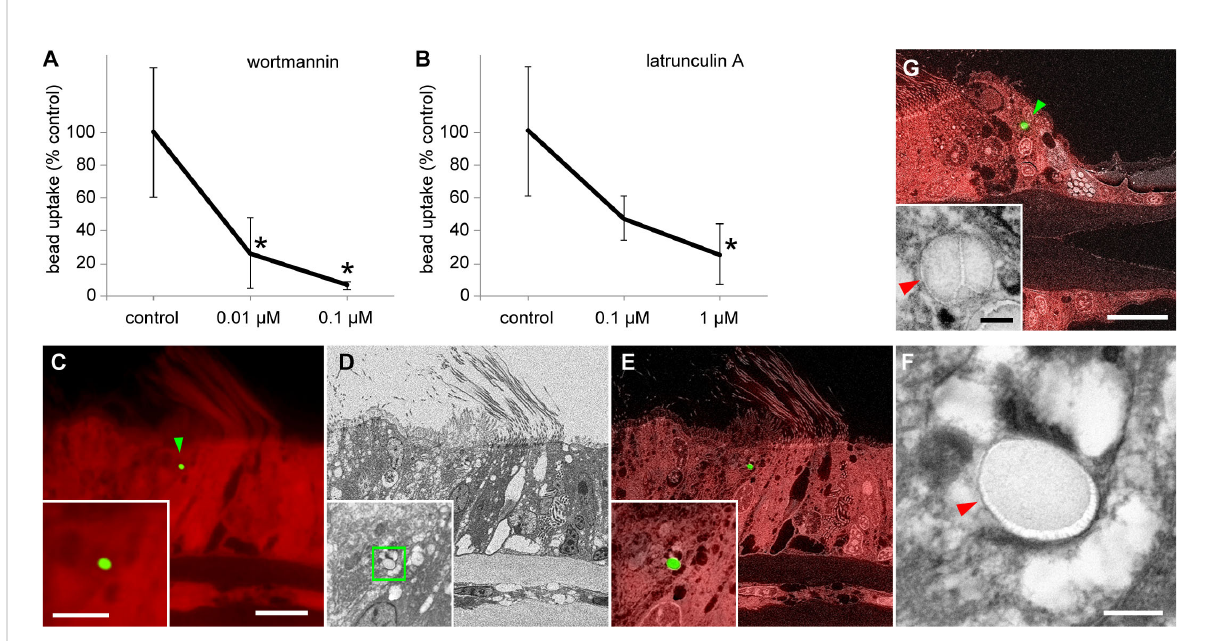
FIGURE 2 Cellular physiological and microhistological veri fi cation of phagocytosis of beads by gill cells. (A, B) Effects of wortmannin (A) and latrunculin A (B) on bead uptake by gill cells. After 24 h of bead exposure and simultaneous treatment with various concentrations of inhibitors, the number of beads internalized into cells was compared with that in control. Asterisks indicate a signi fi cant difference versus the control ( P < 0.05), with error bars representing standard deviation (n = 3). (C – G) Correlative observations of the beads internalized into gill cells using optical and scanning electron microscopy (SEM) with a backscattered electron detector; green arrowheads indicate internalized beads. (C – F) Bathymodiolus japonicus , (G) Perna viridis . (C) Red auto fl uorescence of gill tissues of B. japonicus and green fl uorescent signal of a bead (1 µm). (D) SEM image of the same area as (C) . (E) Merged image of fl uorescence microscopy and SEM. Insets in (C – E) show a higher magni fi cation of the bead in the same area. (F) Magni fi ed image that corresponds to the area indicated by the green square in the inset in (D) The bead is enclosed within a membrane-bound vacuole (red arrowhead). (G) Merged image of red auto fl uorescence of gill tissues of P. viridis and green fl uorescent signal of a bead, and SEM image of the same area. The inset shows a magni fi ed SEM image of this bead. The bead is enclosed within a membrane-bound vacuole (red arrowhead) in a frontal cell. Scale bars: 10 µm in (C) ( applicable to D and E) and (G) ; 5 µm in inset in (C) [applicable to insets in (D, E) ]; 0.5 µm in (F) and inset in (G)